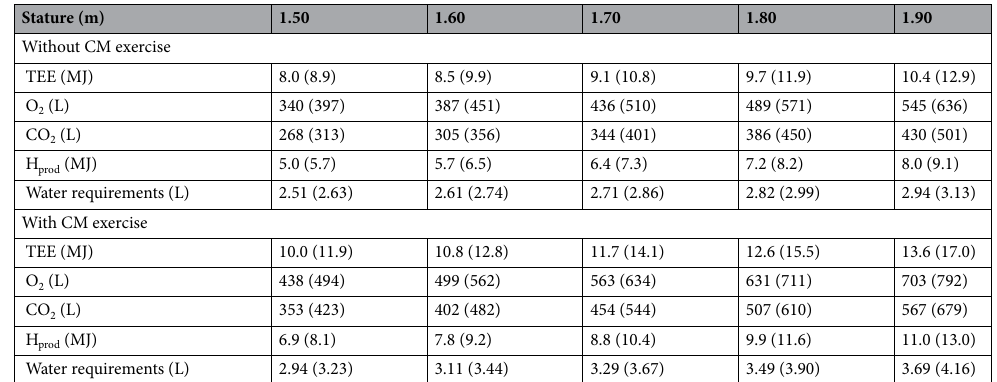
Table 3. A 24-h values for theoretical female astronaut populations without, and with, the use of ISS-like countermeasure (CM) exercise (modelled as two bouts of 30-min of cycle ergometry at 75% VO 2max ) and (in brackets) comparable values from the theoretical male astronaut populations (see 9 ). TEE total energy